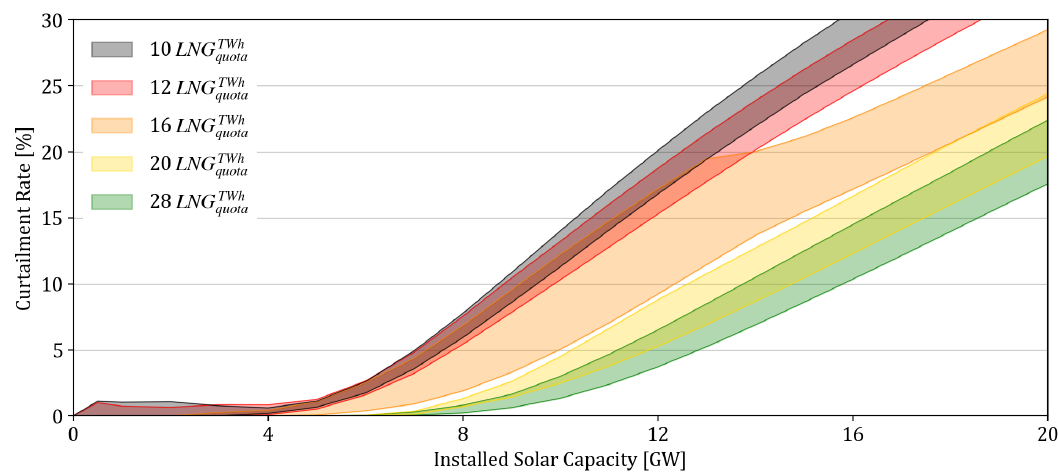
Figure 15. Projected curtailment rates assuming the optimal coal capacity was followed, with the corresponding annual LNG quotas.